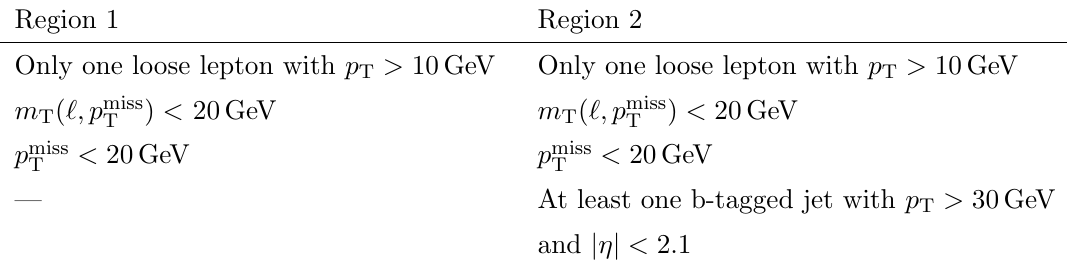
Table 2 . Control regions enriched with misidenti(cid:12)ed leptons used to extract the lepton misidenti- (cid:12)cation rate. Region 1 is used for the dimuon channel. Region 2, with the additional requirement of least one b-tagged jet, is used in the electron-muon channel to reduce semileptonically decaying tt